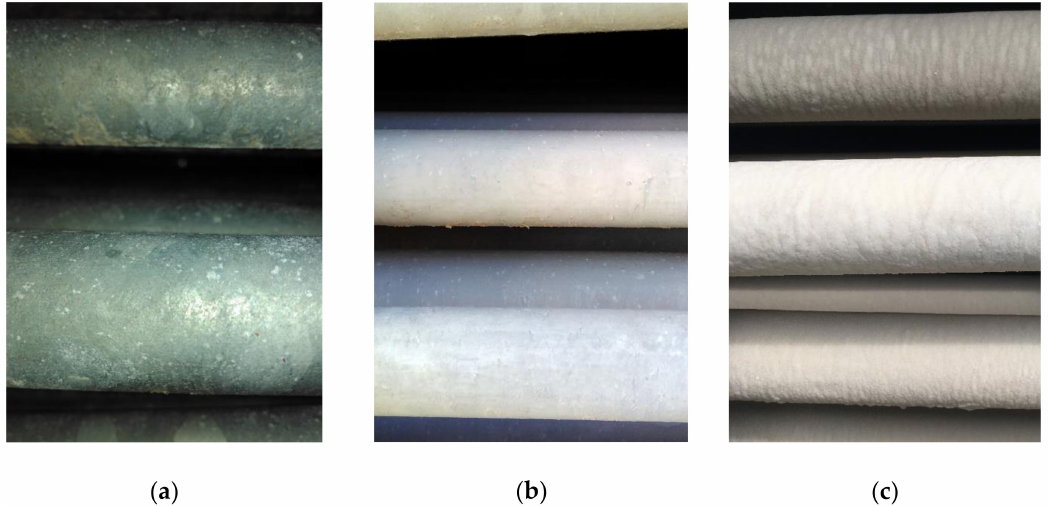
Figure 4. Top tubes after measurements with softened water ( a ) and after 1 ( b ) and 12 ( c ) months of operation with hard water, respectively (Scaling test